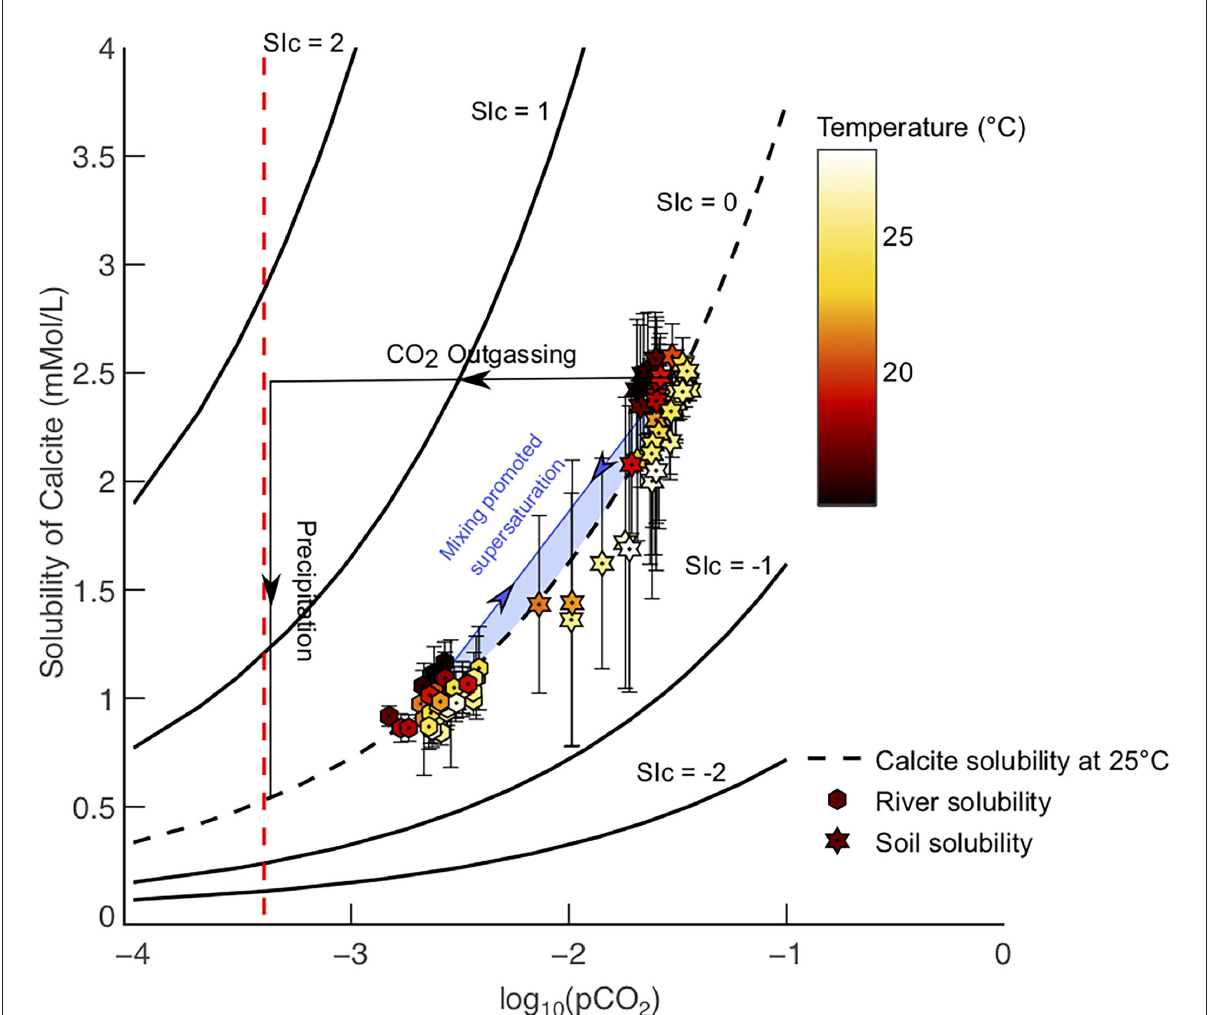
FIGURE5 Schematic figure presenting two plausible mechanisms for calcite precipitation, or supersaturation, to be achieved. River basins with a mean temperature >15 ◦ C and are undersaturated prior to liming (i.e., positive PTCC) are shown with corresponding modelled soil pore water calcite solubilities from Model 1 and 2 (i.e., SIc = 0). Atmospheric pCO 2 is shown as the red line. Precipitation may be triggered either by soil waters degassing when in contact with the atmosphere, or mixing with river waters, creating fluids with even higher SIc values (blue shaded area). Supersaturation via mixing is exacerbated further when river waters are saturated with calcite. All SIc contours are calculated for 25 ◦